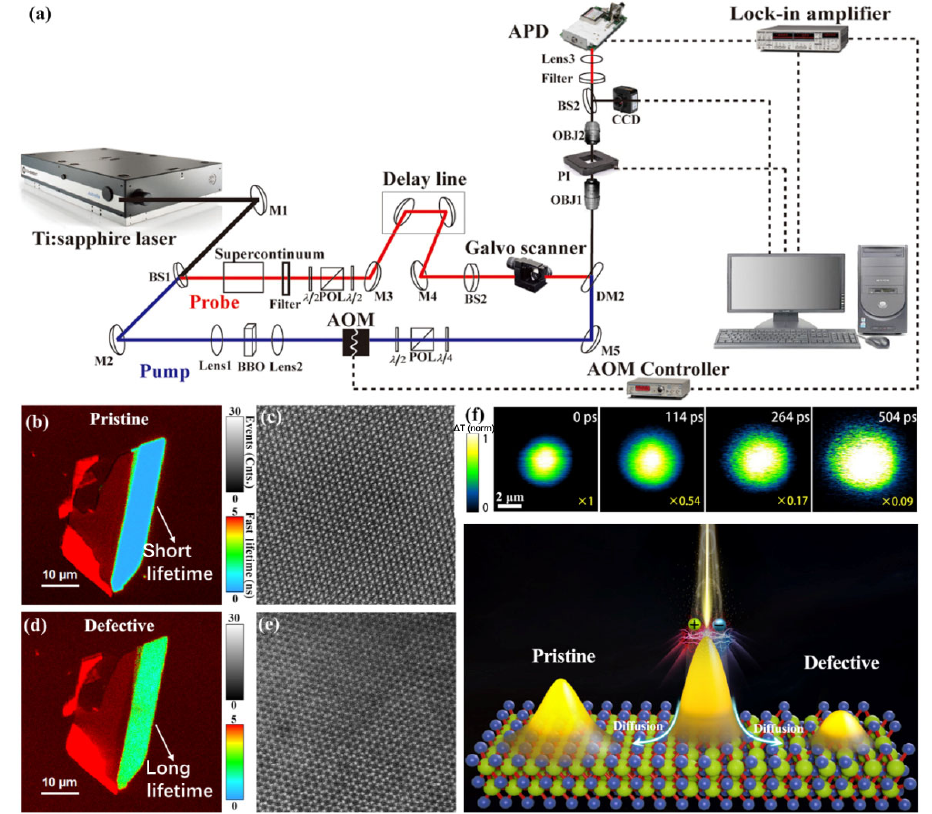
Fig. 10 (a) Schematic of the femtosecond transient absorption microscopy. (b–e) Defects bind excitons to form defect-induced excitons with a long lifetime. (f) Directly visualization of exciton transport in WS 2 . Reproduced with permission from Ref. [140] for (a, f), © WILEY-VCH Verlag GmbH & Co. KGaA, Weinheim 2019; Reproduced with permission from Ref. [141] for (b–e), © The Royal Society of Chemistry